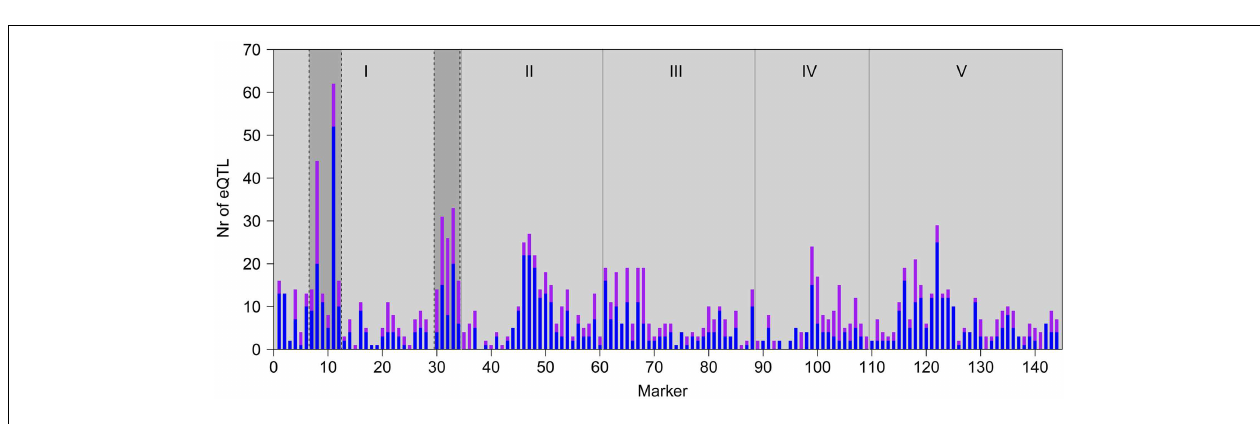
detected at each marker position. Gray vertical lines depict chromosomal borders, chromosomes (I-V) are indicated at the top. Cvi introgressions of LCN1-10 are indicated by the darker gray areas on chromosome I.